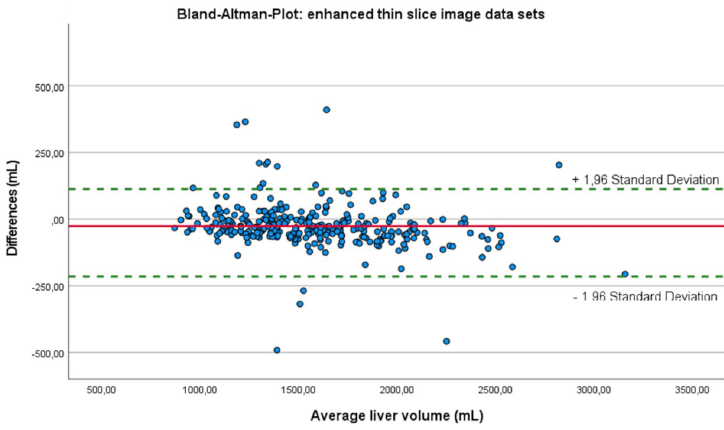
Fig 4. Correlation between manual and automated liver segmentation for enhanced image data sets.